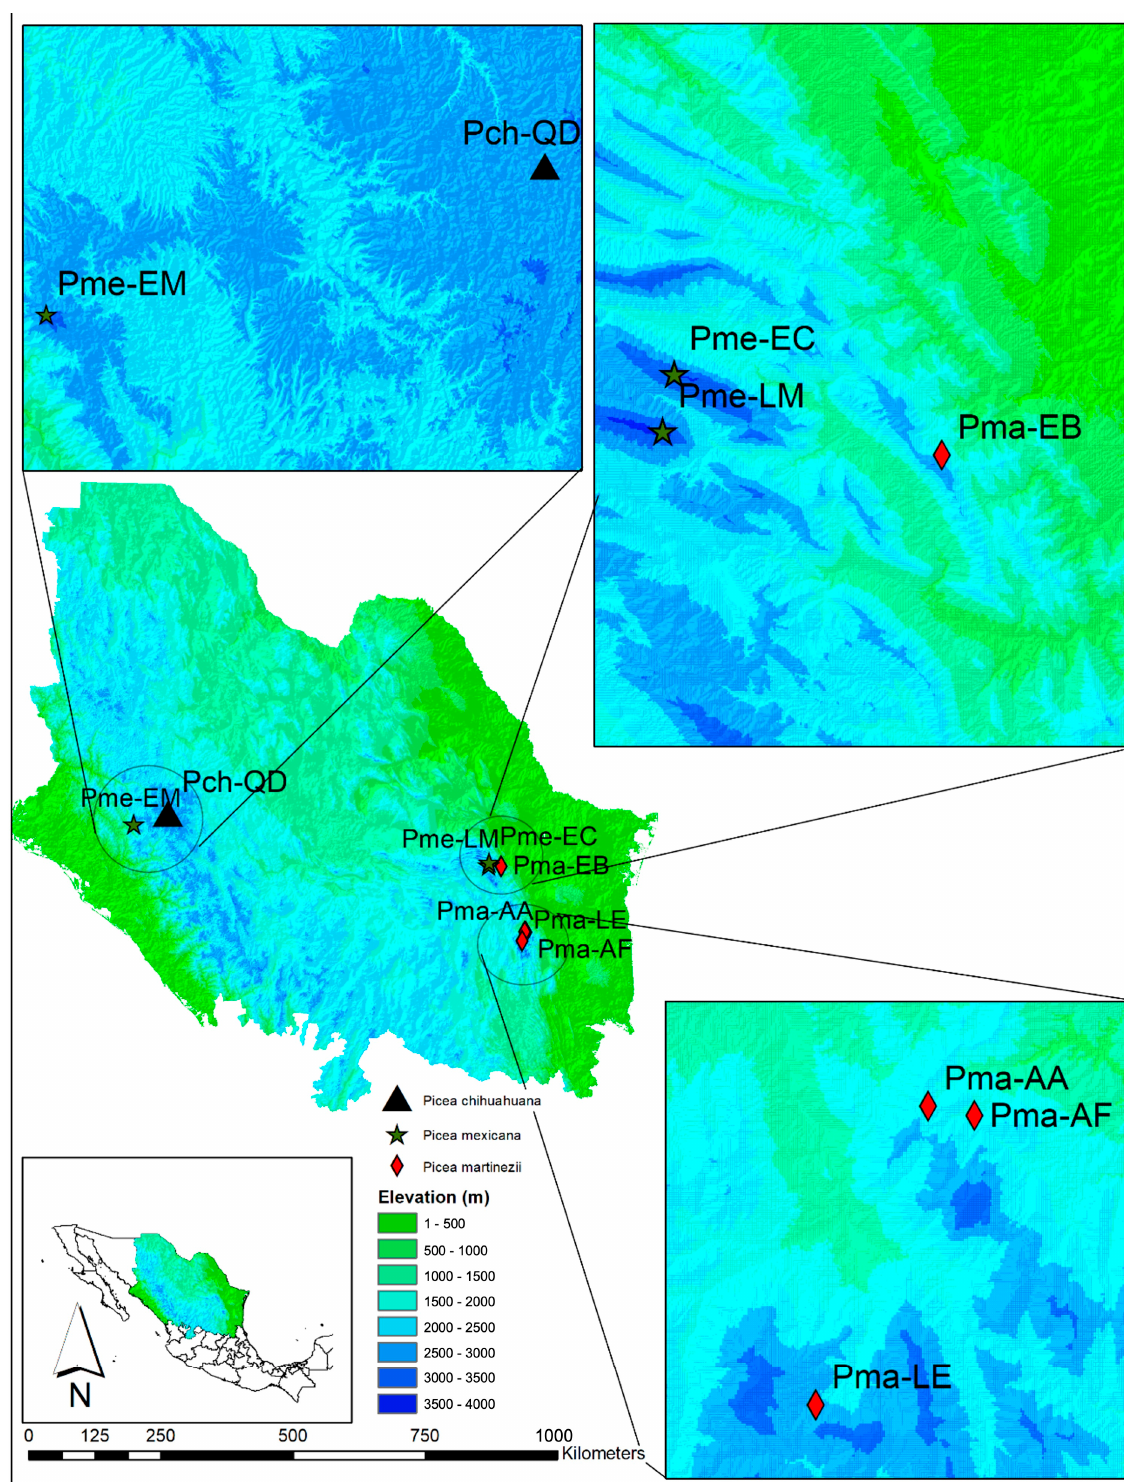
Figure 1. Locations of the eight provenances of the three Mexican spruces under study. Picea chihuahuana Quebrada de los Durán (Pch-QD); P. martinezii provenances of Agua Fría (Pma-AF), Agua Alardín (Pma-AA), El Butano (Pma-EB) and La Encantada (Pma-LE); P. mexicana provenances of El Mohinora (Pme-EM), La Marta (Pme-LM) and El Coahuilón (Pme-EC).